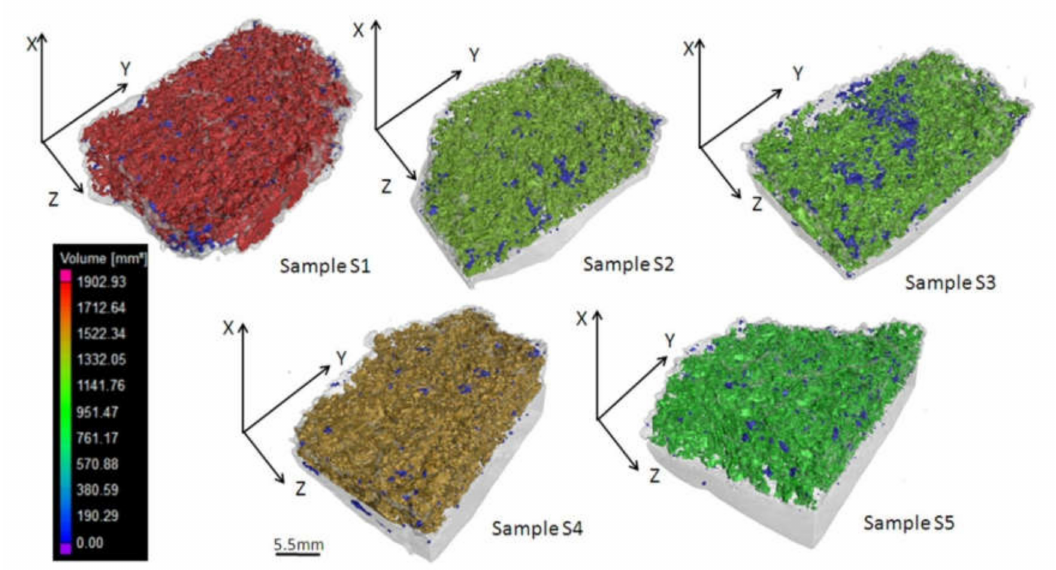
Figure 9. The three-dimensional (3D) visualization of CT data for samples S1, S2, S3, S4, and S5; the sample was positioned with the composite 2 material facing